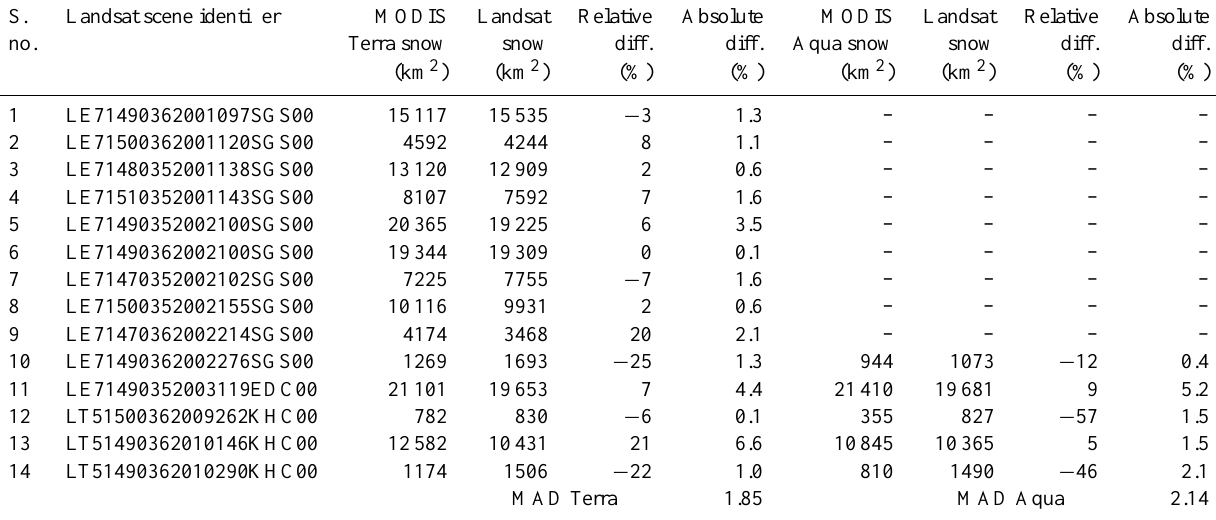
Table 3. Results of the MODIS Terra and Aqua product validation against the Landsat images under clear sky conditions. S.